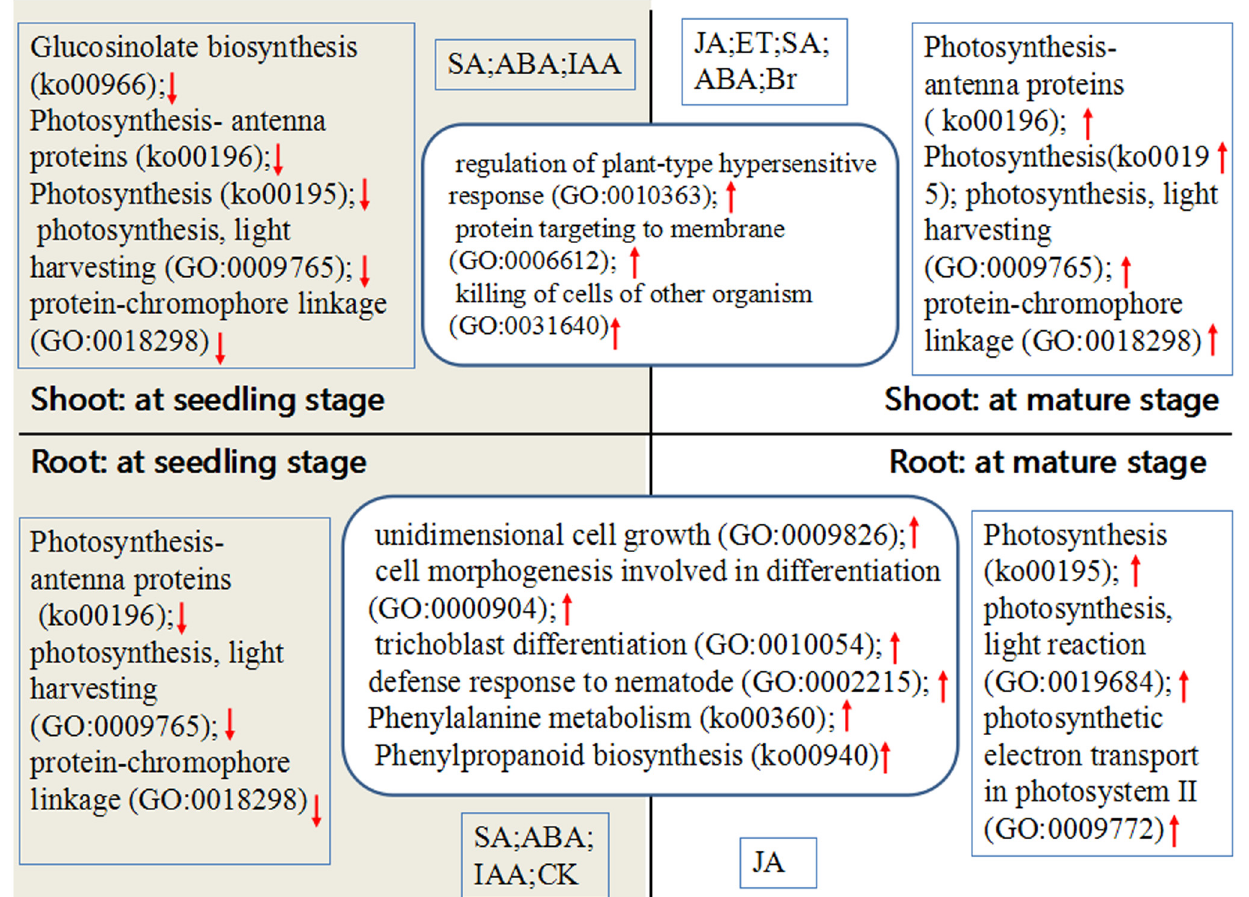
Fig 9. A putative model for the response mechanism of plant to FZB42 volatiles at different tissues and growth stages. The arrow up or down represent the up or down of genes related to GO and KEGG